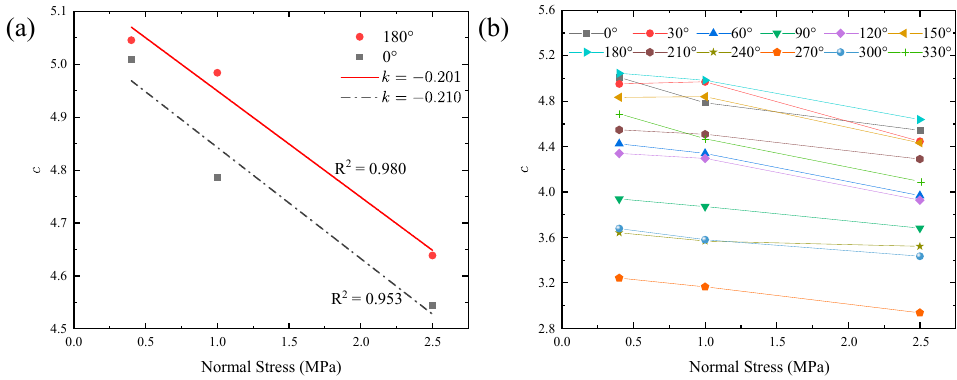
Figure 16. Curves of parameter c vs. normal stress: ( a ) 0° and 180° analyzed directions, ( b ) analyzed direction between 0° and 360° at an interval of 30°.